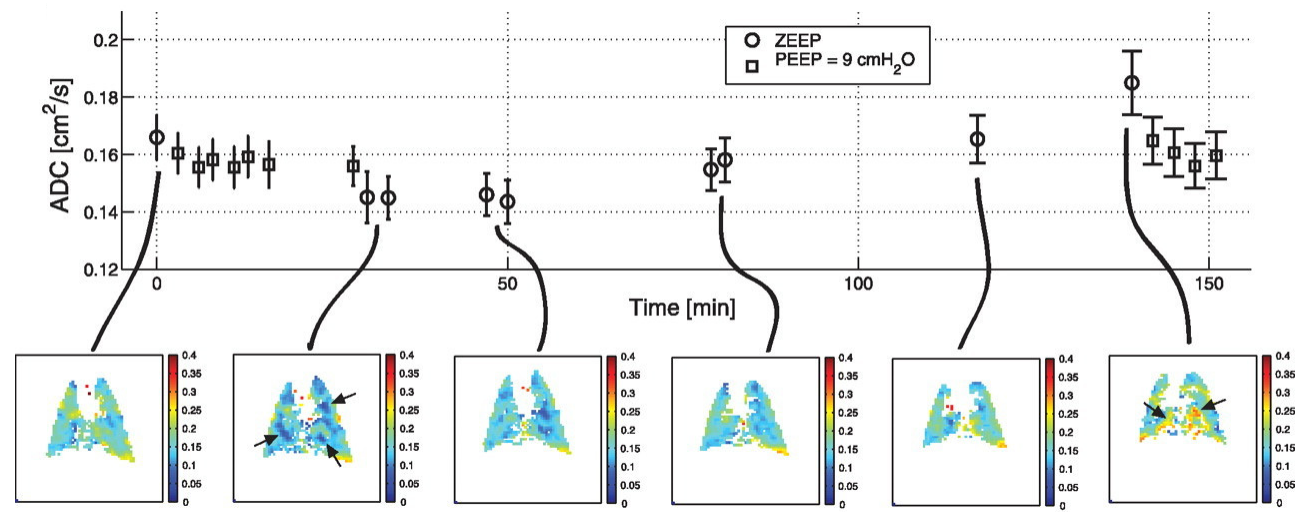
Figure 11. An anesthetized rat, initially imaged after one hour of tidal ventilation, undergoes a ‘recruitment’ maneuver consisting of Positive End-Expiratory Pressure (PEEP), causing the average ADC to decrease. During a subsequent period of 100 min of tidal ventilation, mean ADC increases by approximately 20% due to localized atelectasis. Re-recruitment returns the ADC to baseline. The black arrows highlight regions of regionally reduced (left) or increased (right) ADC that appear immediately before or after recruitment. Reprinted from Cereda, et al . ( J Appl Physiol 2011, ref. [43] ) with permission.